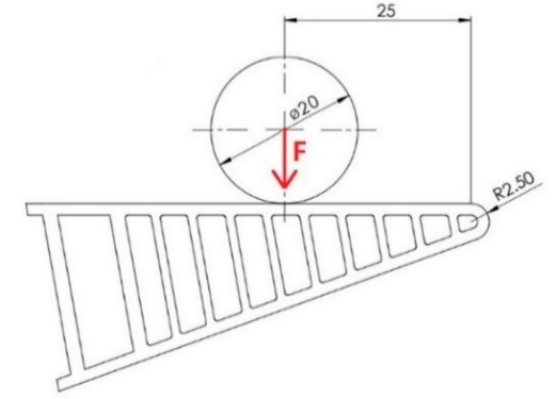
Figure 3. Loading of the testing finger.